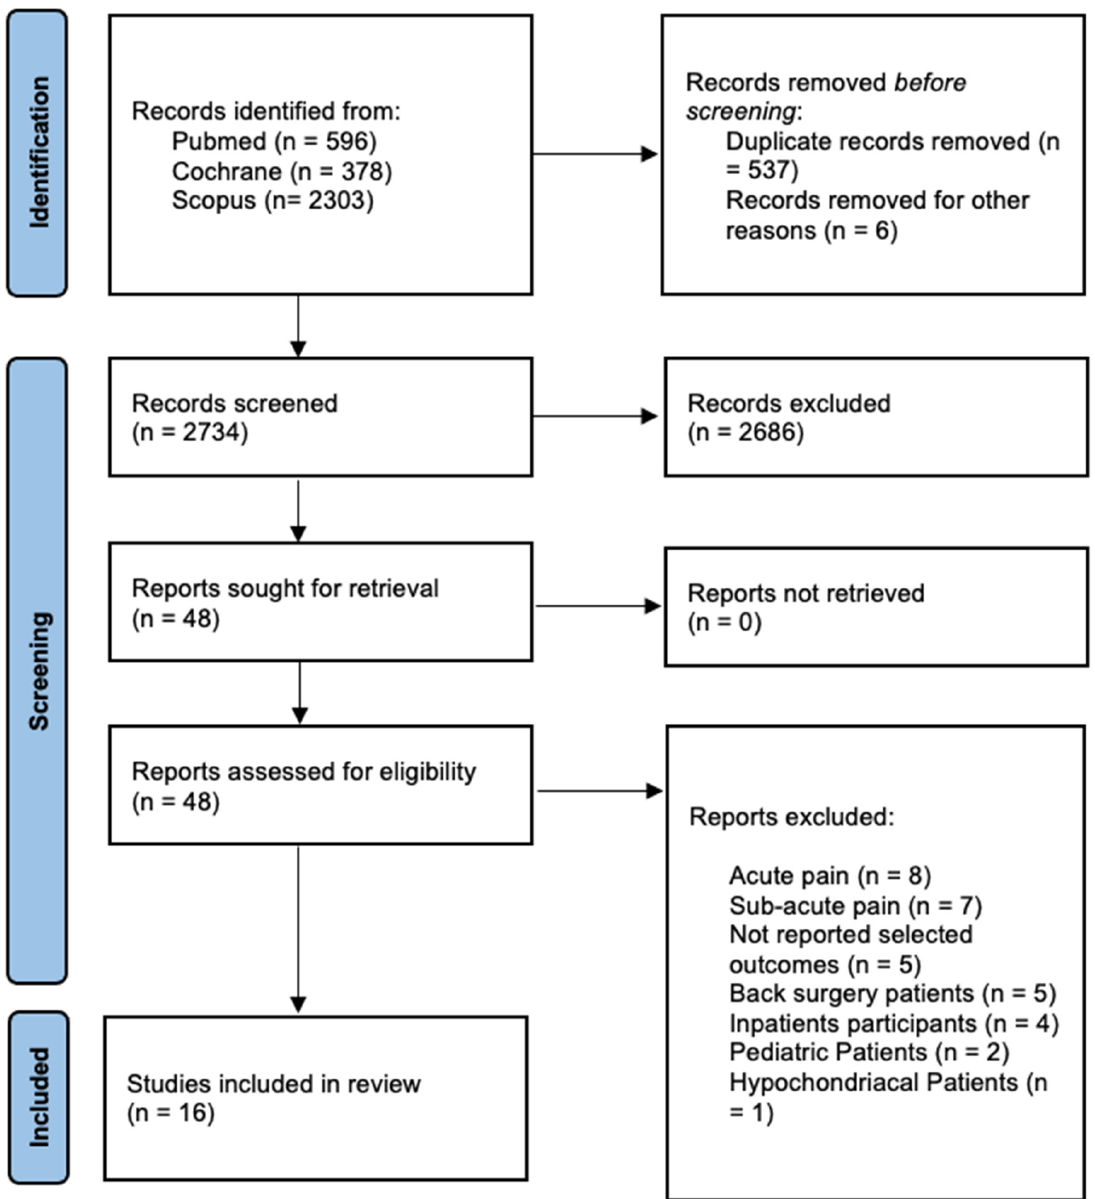
Figure 1. Preferred reporting items for systematic review and meta-analysis (PRISMA 2020).